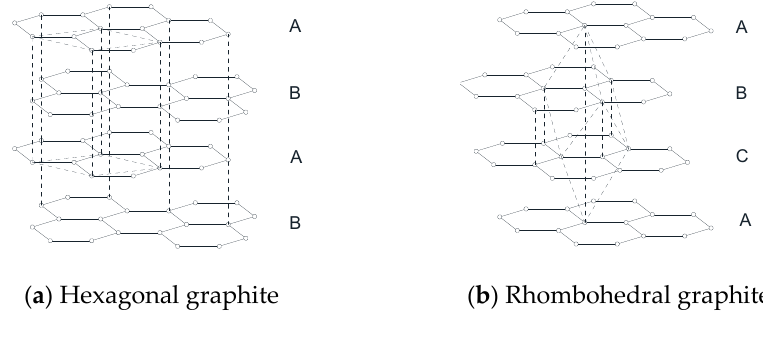
Figure 1. Crystal structures for two modifications of graphite. ( a ) Hexagonal graphite; ( b ) Rhombohedral graphite.